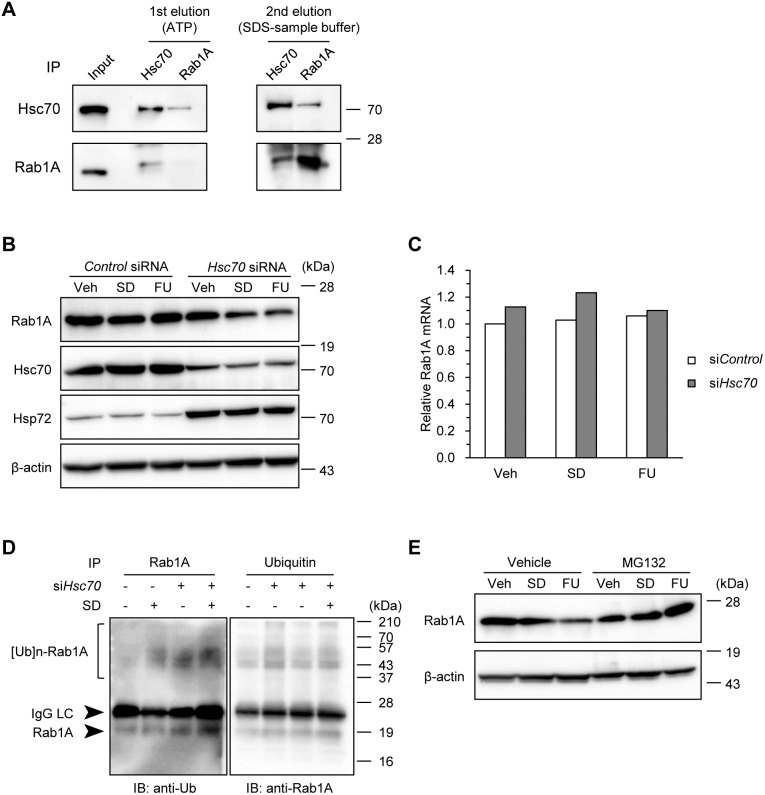
Hsc70 prevented Rab1A degradation.(A) Hsc70-Rab1A interaction through chaperone activity. HT29 cells were subjected to serum depletion for 24 h, and then lysed. To verify the interaction between Hsc70 and Rab1A in a chaperone-dependent manner, anti-Hsc70 or anti-Rab1A immunoprecipitant was eluted with ATP, followed by elution with SDS sample buffer and immunoblotting in order to confirm the bait proteins. (B) Hsc70 knockdown decreased the level of Rab1A protein under stress conditions. HT29 cells transfected with Hsc70 or control siRNA were subjected to serum depletion, 5-FU, or vehicle treatment for 24 h. Immunoblotting for endogenous Rab1A and Hsc70 proteins. β-actin was used as a loading control. (C) Hsc70 knockdown did not decrease Rab1A mRNA level. After knockdown of Hsc70 and in the control, Rab1A mRNA levels were determined by qPCR at 48 h post-transfection. (D) Hsc70 knockdown promoted the ubiquitination of Rab1A. After Hsc70 knockdown or control cells were lysed, immunoprecipitation (IP) with anti-Rab1A or anti-ubiquitin antibodies was performed, followed by immunoblotting with anti-ubiquitin or anti-Rab1A antibodies. (E) MG132 treatment inhibited Rab1A degradation. Hsc70 knockdown cells were subjected to serum depletion or 5-FU treatment, and then MG132 (10 µM) or vehicle was added for the last 8 h before sampling. SD, serum depletion. FU, 5-fluorouracil. Ub, ubiquitin, IgG LC, immunoglobulin light chain. Data (except in C) are representative of at least two separate experiments yielding similar results.